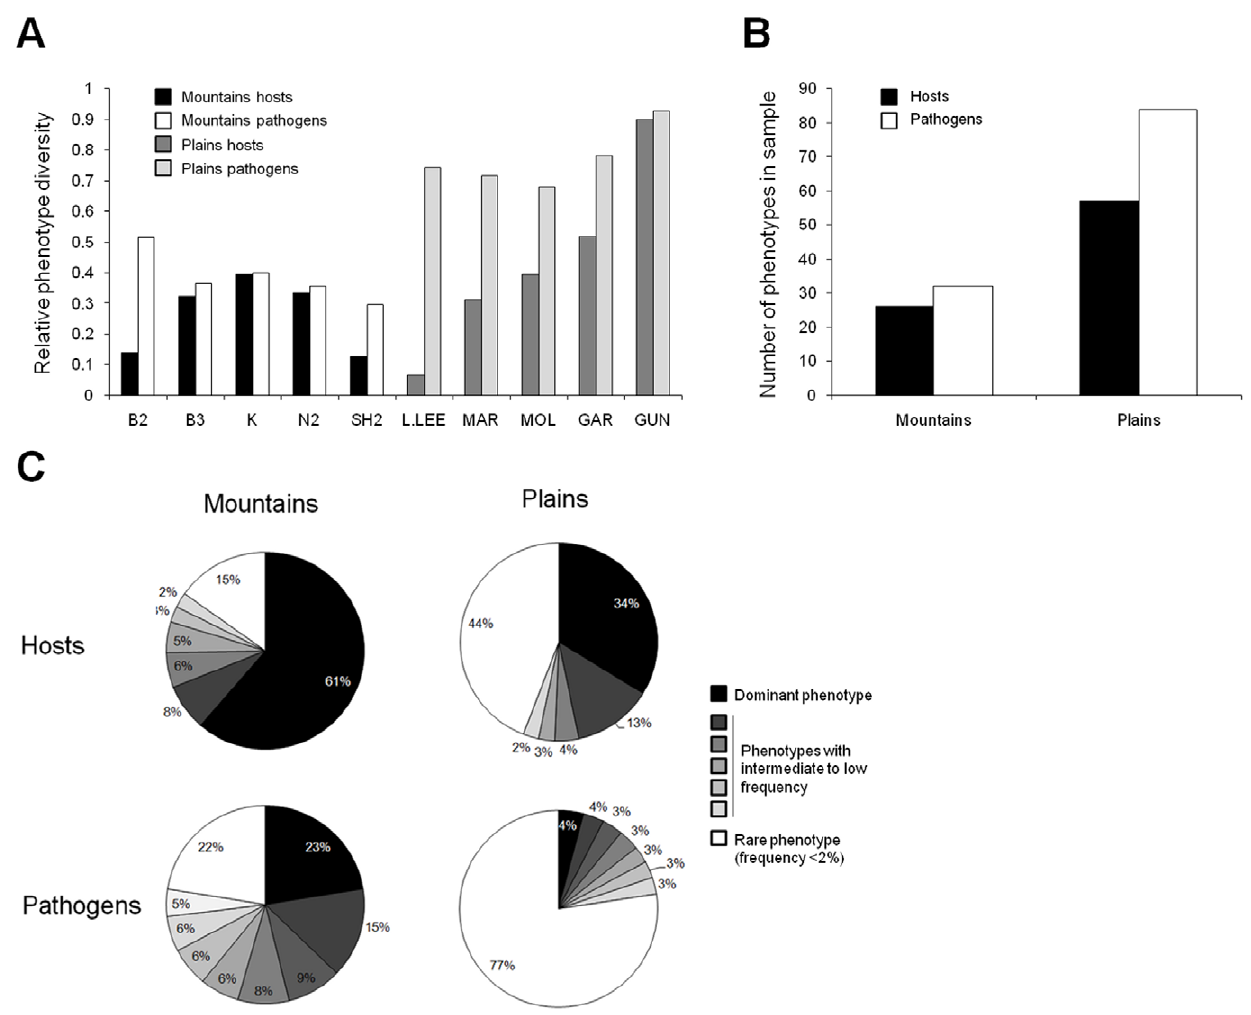
Figure 4. Diversity in resistance of L.marginale and infectivity of M.lini in Mountains and Plains regions. (A) Relative phenotype diversity was calculated as the ratio of phenotypes found per population over the number of individuals tested. A value of 1 would mean that all individuals tested were different in the assay. (B) The total number of phenotypes in each region calculated for both host and pathogen. (C) The relative frequency in the region of different phenotypes plotted for host and pathogen in Mountains vs Plains. Phenotypes occurring at a frequency of less than 2% were characterized as ‘‘rare’’ and grouped.